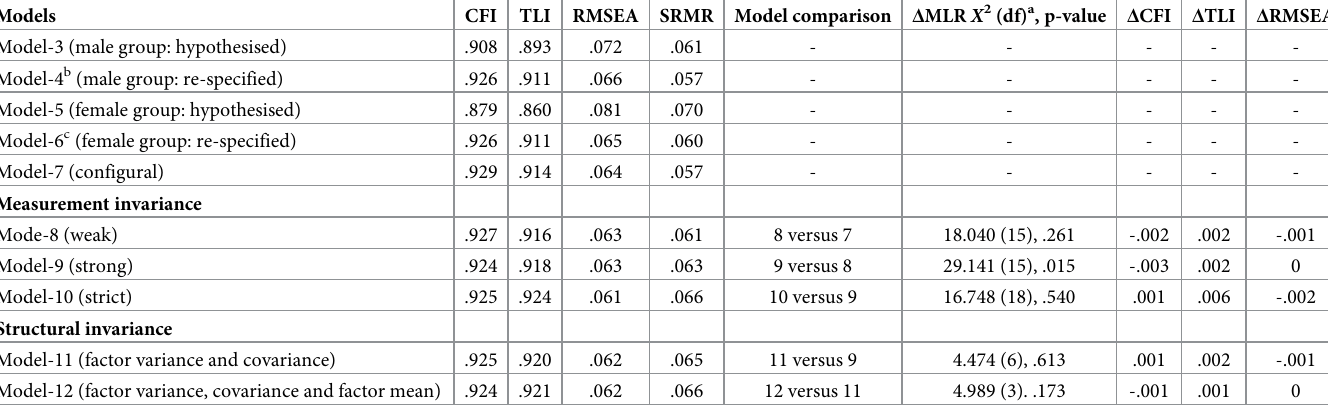
Table 3. The Psychological Need Satisfaction in Exercise Malay version (PNSE-M) baseline model fit results and tests of measurement invariance.